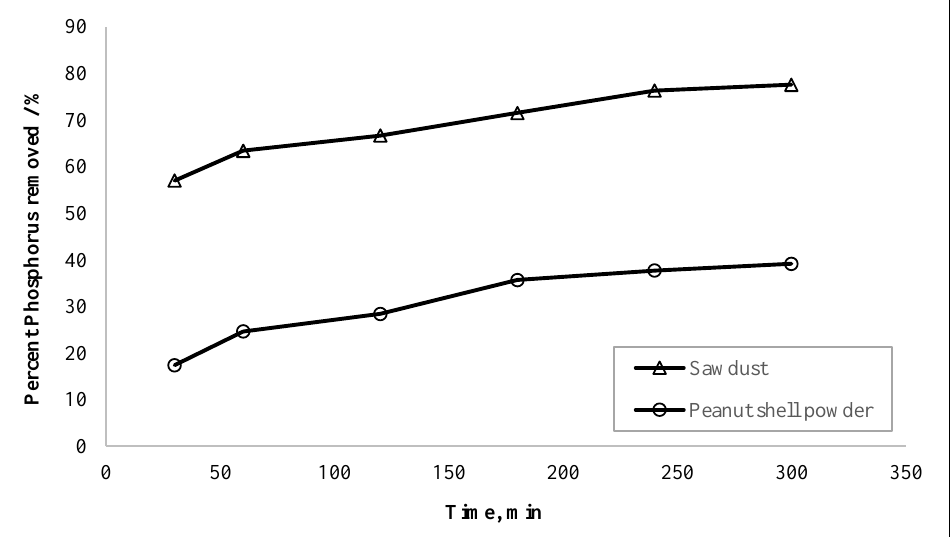
Figure 2. Effect of contact time on phosphorus